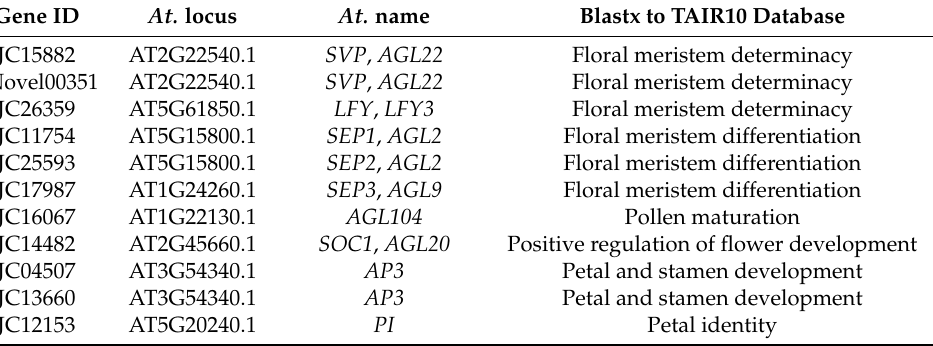
Table 4. The DEGs associated with MADS-box transcription factors after GA 3 treatment in J.